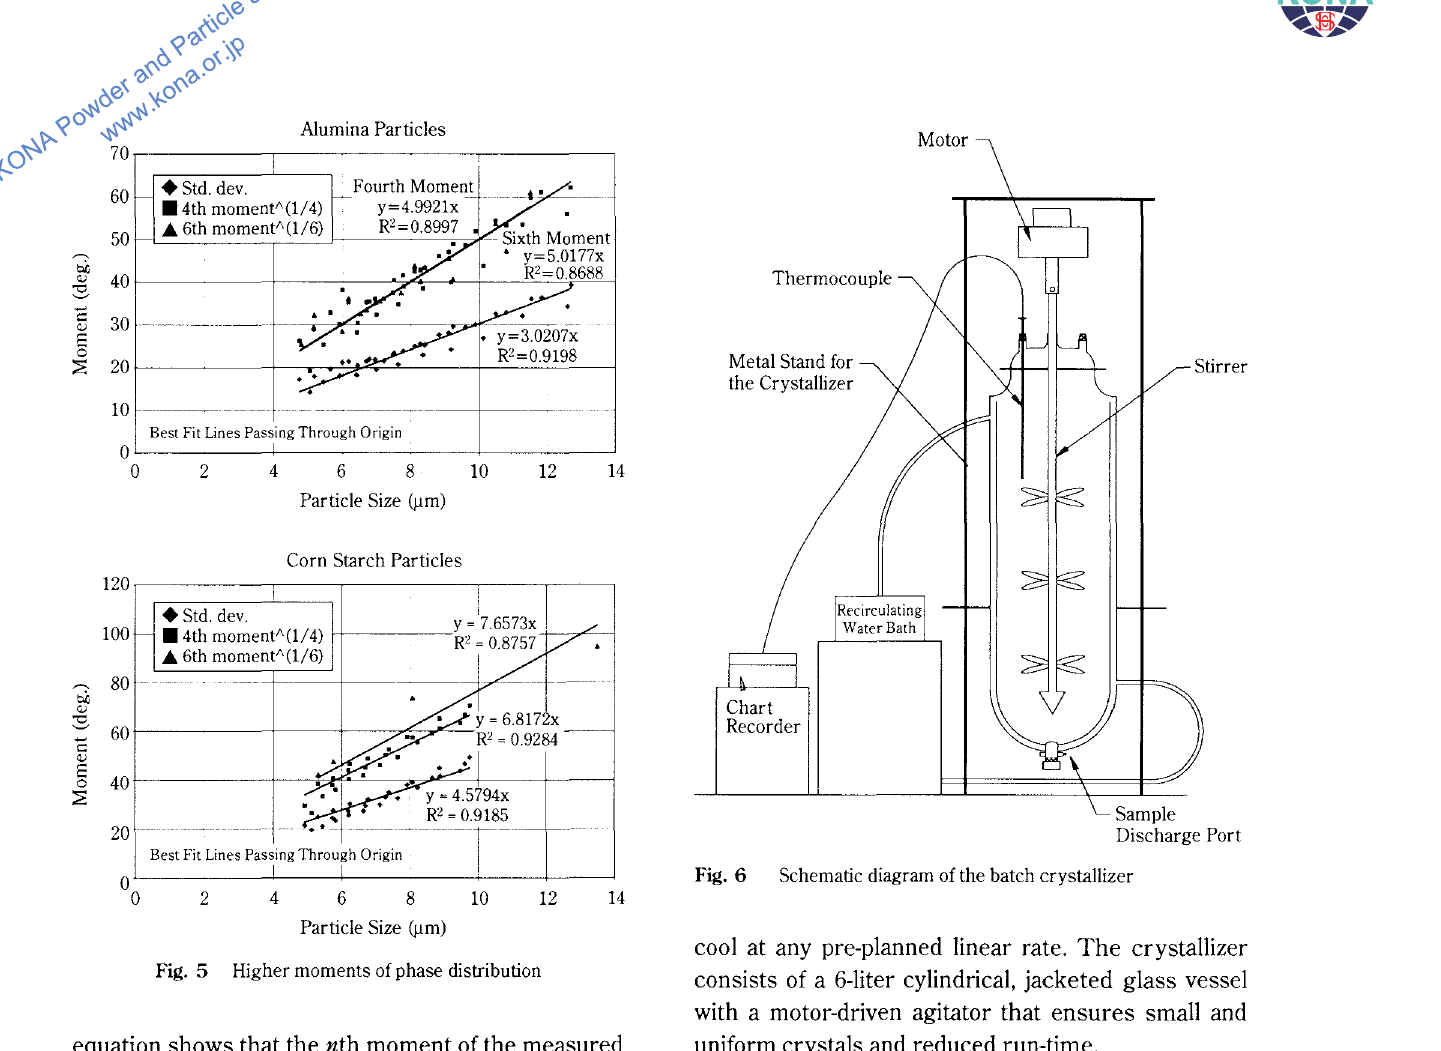
Fig. 5 Higher moments of phase distribution